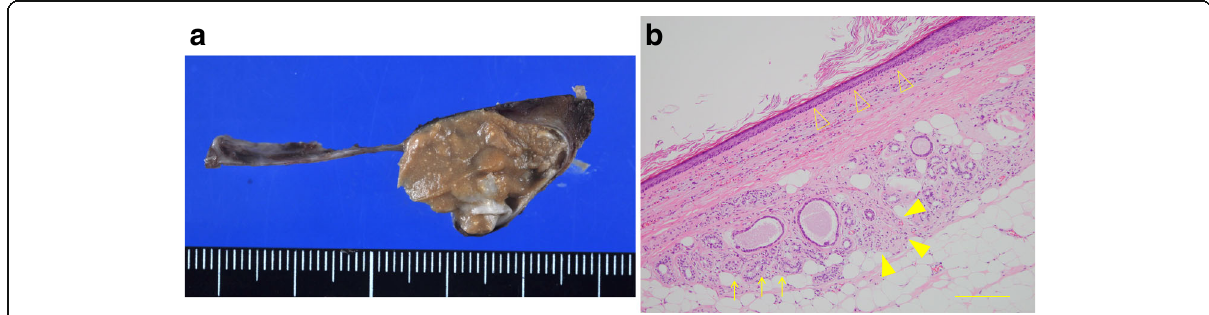
Fig. 4 Macroscopic appearance ( a ) and microscopic findings ( b ) of a section of the resected teratoma. The cyst wall was mainly composed of keratinizing stratified squamous epithelium ( △ ). Fat, sweat glands (arrows), and peripheral nerves ( ▲ ) were observed around the cyst wall, and the pathological diagnosis was mature teratoma. The scale bar represents 200 μ